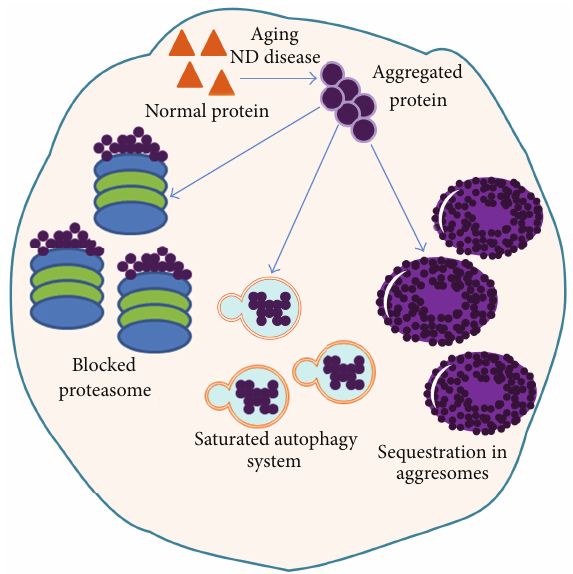
Figure 1: Protein aggregates formed during aging and PMDs impair diverse cellular clearance